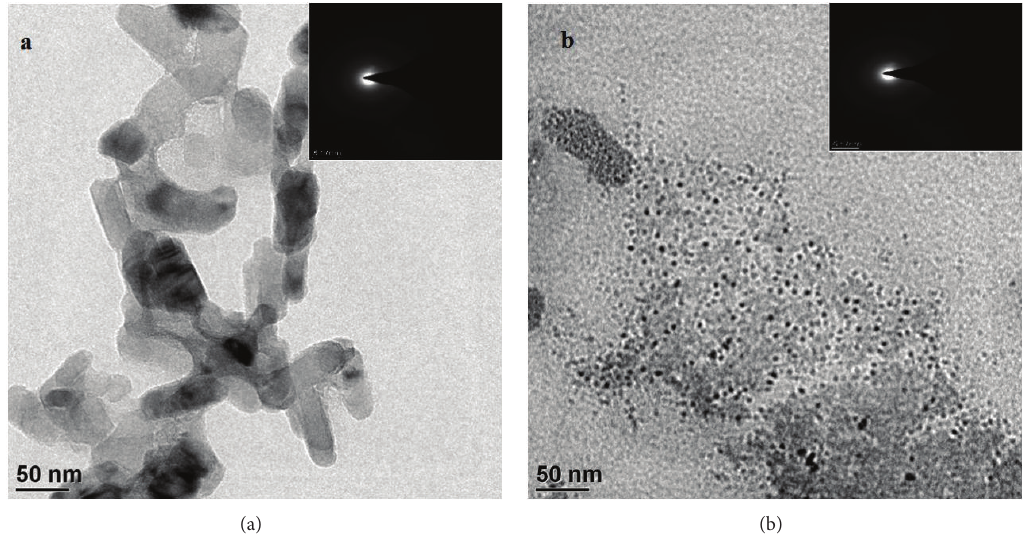
Figure 2: TEM images of cerium oxide nanoparticles (a) without DDSA and (b) with DDSA.